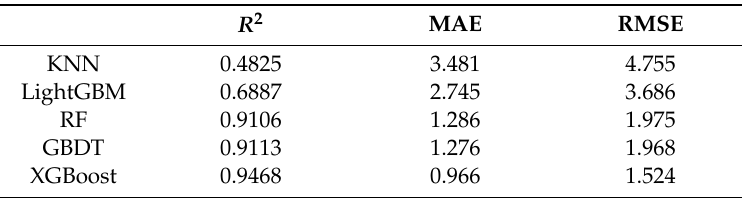
Table 3. Evaluation of the single